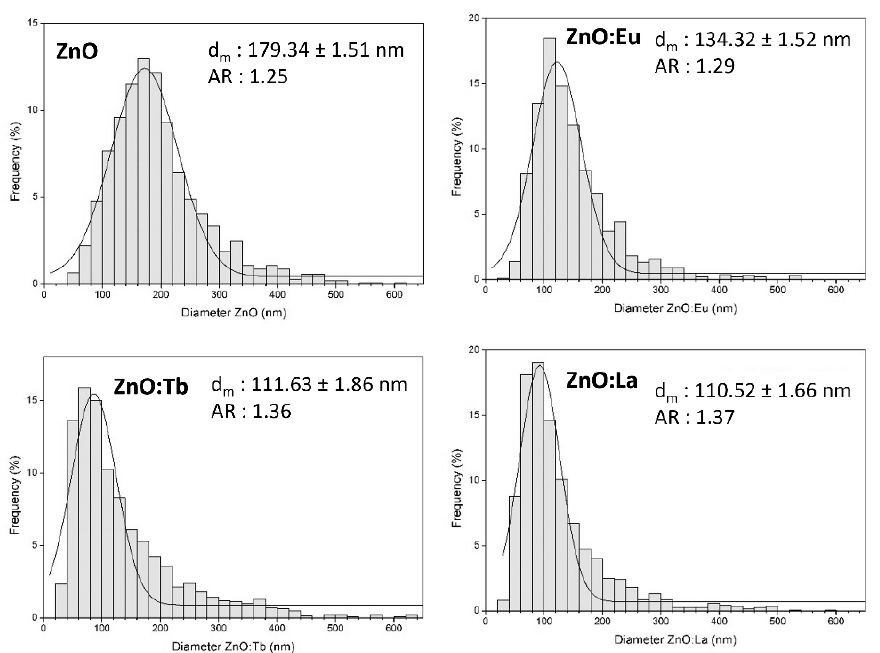
Figure 2. Size distribution histogram determined from TEM for different assemblies of nanocrystals from samples ZnO, ZnO:Eu, ZnO:Tb, and ZnO:La. Table 1. Morphological and size distribution from TEM micrographs of ZnO, ZnO:Eu, ZnO:Tb, and ZnO:La